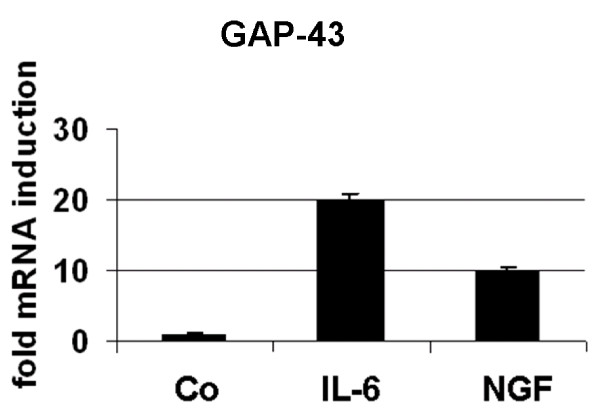
Changes in expression of GAP-43- mRNA levels in IL-6- versus NGF-stimulated PC12 cells. qRT-PCR analyses were performed as described in the Methods section.